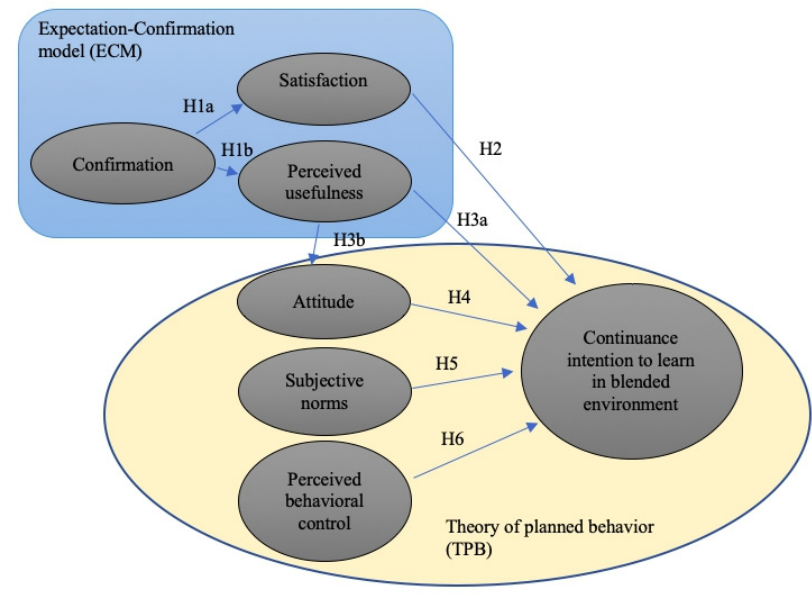
Figure 1. The research framework of the study.